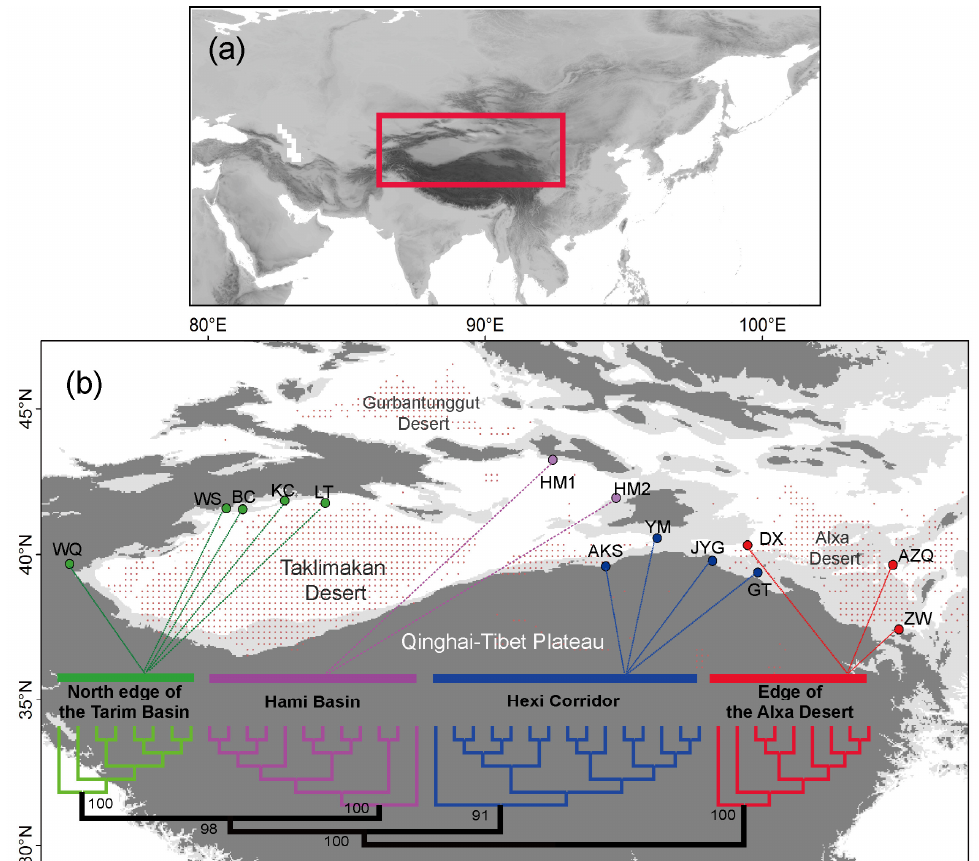
Figure 1. Highlight of the study area ( a ) and the geographical distribution of 14 sampled Gymnocarpos przewalskii populations ( b ). The bottom of ( b ) showed neighbor-joining (NJ) phylogenetic tree of 44 individuals from 14 sampled populations constructed with the genome-wide single nucleotide polymorphisms (SNPs) dataset. The numbers under the branches showed the bootstrap values of the nodes (%). Light–dark gradients of colors indicated the changes of elevation from low to high. The colored dots for 14 populations showed the different population groups.